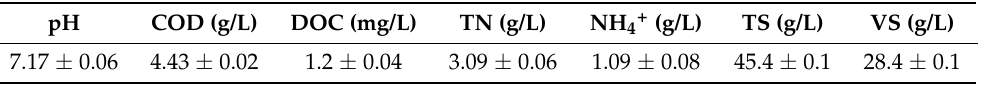
Table 1. Basic physicochemical characteristics of the